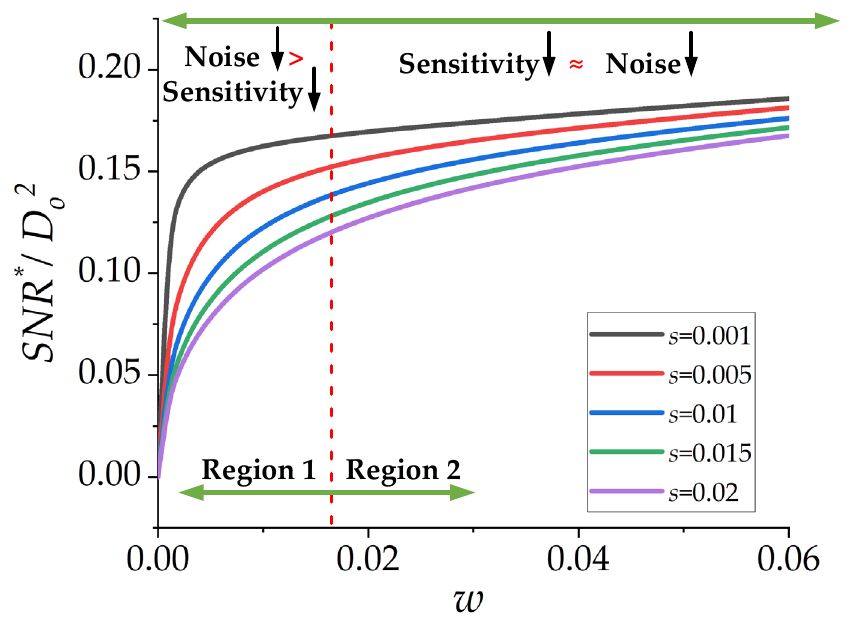
Figure 4. SNR * / D o2 as a function of the normalized track width ( w ) for different s while d i = 0.01.